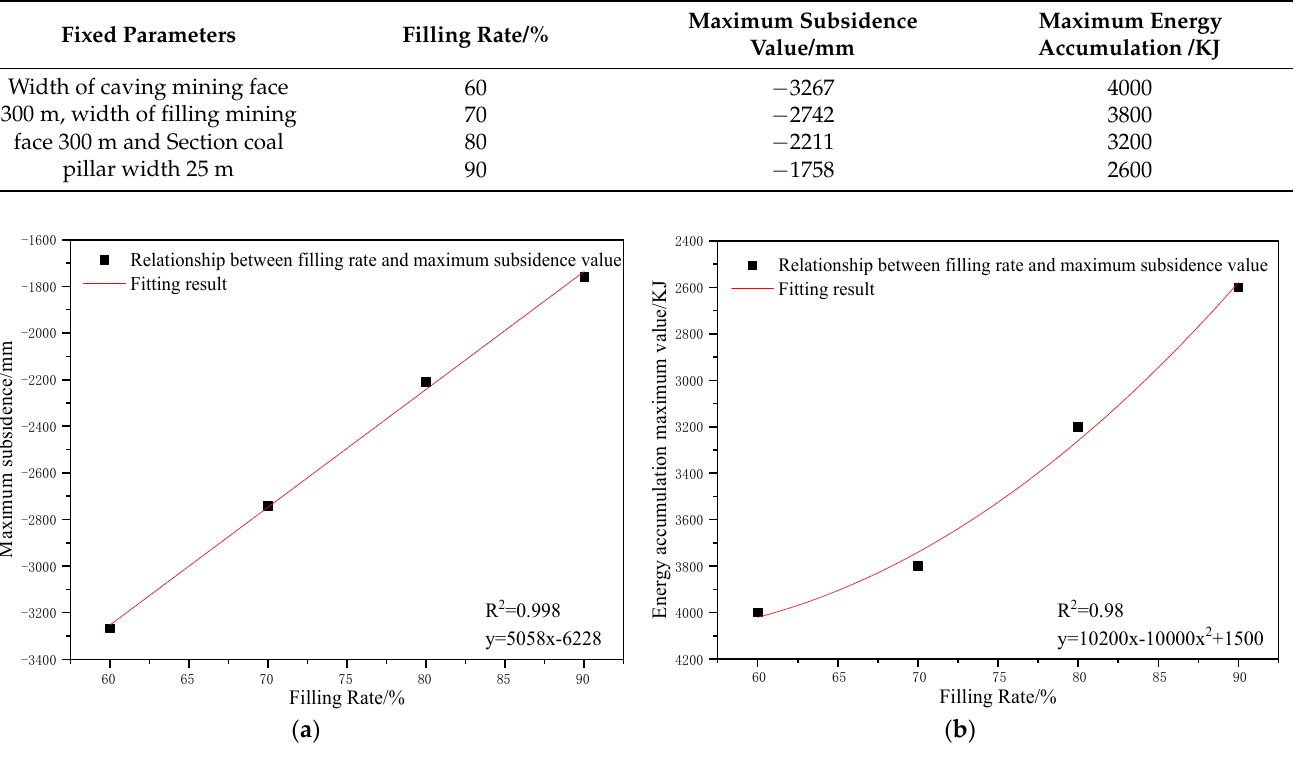
Figure 9. Influence of filling ratio on the control effect of partial filling mining based on the main key stratum; ( a ) relationship between filling ratio and maximum surface subsidence. ( b ) Relationship between filling ratio and energy accumulation maximum value.